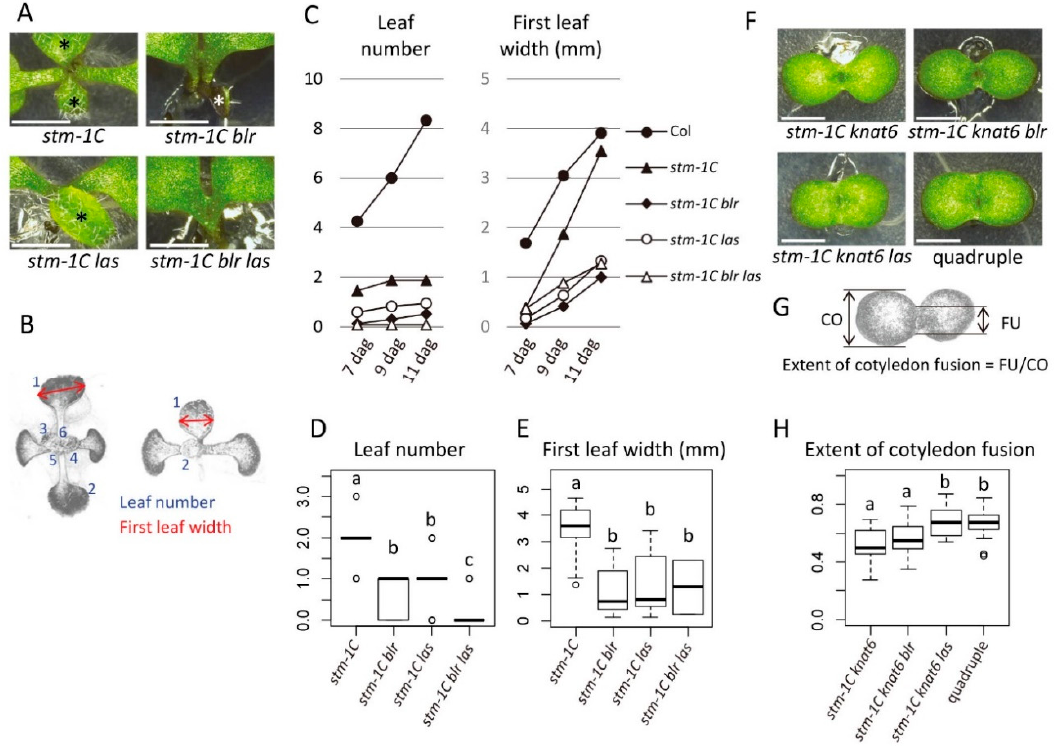
Figure 3. Genetic interactions of stm, las, blr , and knat6 mutants. ( A ) The las mutation enhances the shoot production phenotype of stm-1C and stm-1C blr mutants. Shoot apex at 9 dag. Asterisks indicate developing leaves. ( B ) Examples of shoot phenotype measurements in the wild-type Col ( left ) and stm-1C ( right ). ( C ) Change in leaf number ( left ) and first leaf width ( right ). ( D , E ) Box plots of leaf number ( D ) and first leaf width ( E ) at 11 dag. ( F ) las enhances the cotyledon fusion phenotype of stm-1C knat6 and stm-1C knat6 blr mutants. Seedlings at 7 dag. ( G ) Quantification of cotyledon fusion. ( H ) Box plot showing extent of cotyledon fusion at 7 dag in each genotype. Di ff erent letters in box plots indicate statistically significant di ff erences ( p < 0.01, Steel–Dwass method for ( D ); p < 0.05, Tukey–Kramer method for ( E ) and ( H )). Sample size is 24, 23, 17, and 23 for ( C ) ( left ) and ( D ); 24, 12, 13, and 2 for ( C ) ( right ) and ( E ); and 11, 23, 12, and 19 for ( H ). Bars in ( A ) and ( E ), 2 mm.